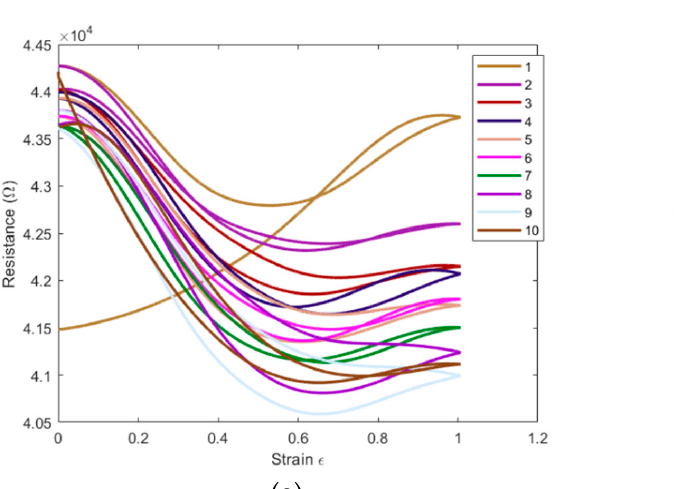
Figure 17. KD cyclic tensile test results: ( a ) Resistance vs. strain for ten cycles. ( b ) Stress vs. strain for ten cycles. ( c ) Resistance vs. strain and gauge factors for the first and the tenth cycles. ( d ) Displacement, force, and resistance change over time for ten cycles.